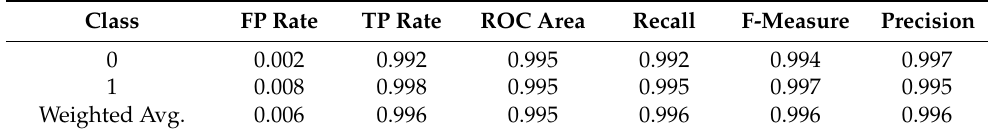
Table 16. Evaluation metrics for SVM.